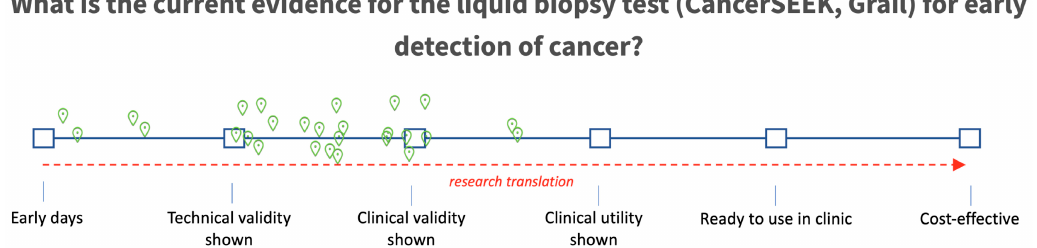
Figure 1. Example of an evidence slider with which the translational research phase was determined. Each workshop participant could vote once (green dots) following a discussion about this case in the break-out sessions. The individual votes are used to construct density plots.